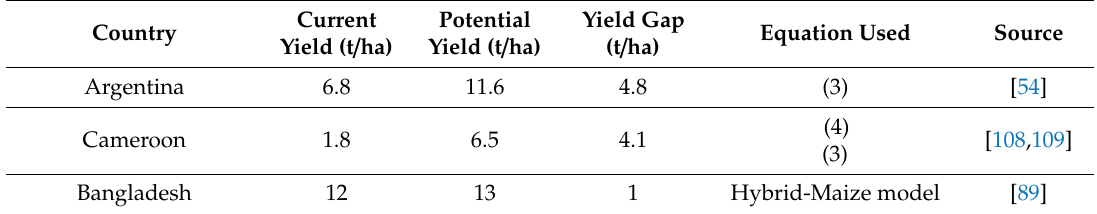
Table 3. Attainable and potential yield of maize in some